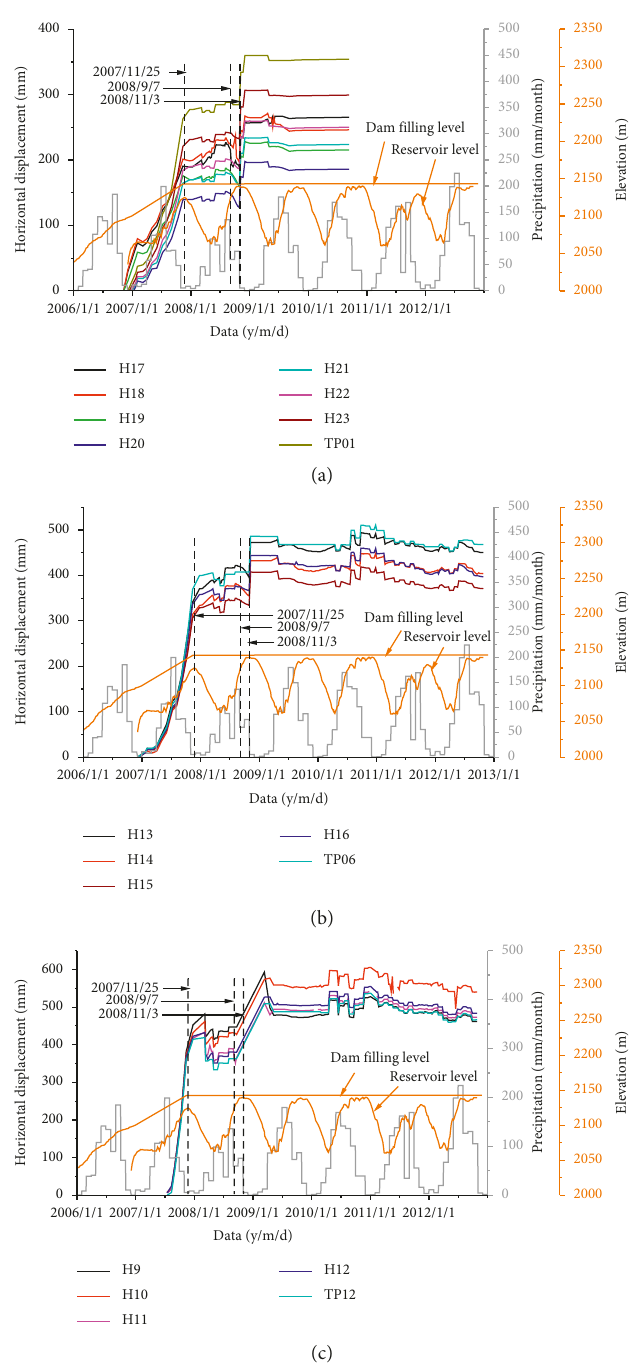
Figure 7: Evolution of horizontal displacements with time in the Qiaoqi dam. (a) EL. 2061; (b) 2085m; (c) EL. 2110